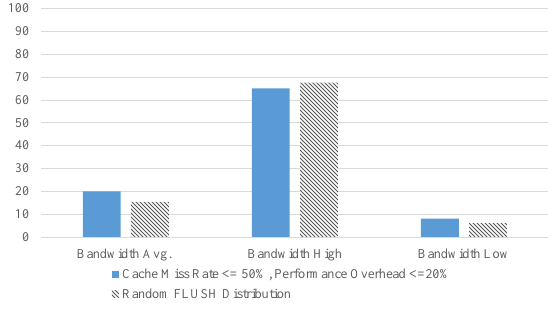
Figure 6. Side-channel bandwidth (bps) with and without adaptive mechanism.